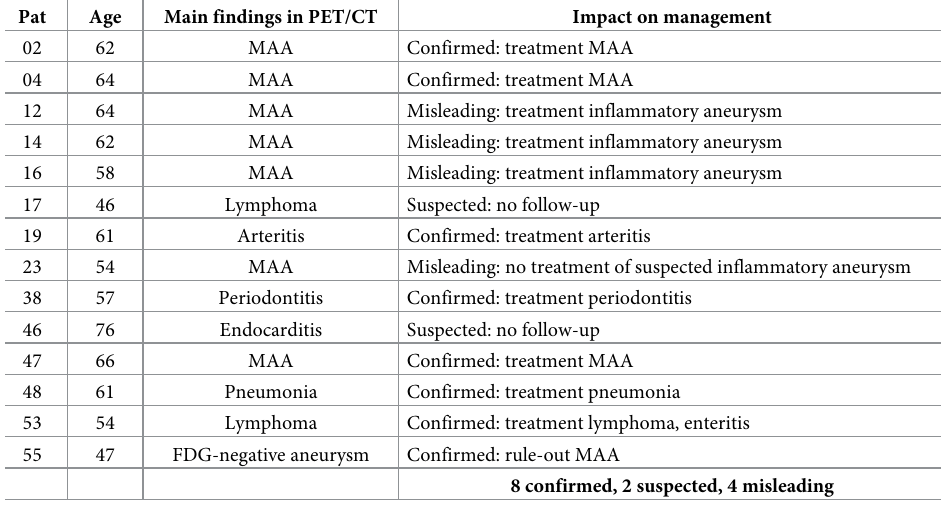
Table 3. Impact on patient management of baseline PET/CT scans with the referral question: MAA, other infec- tion or lymphoma (n = 14). Pat Age Main findings in PET/CT